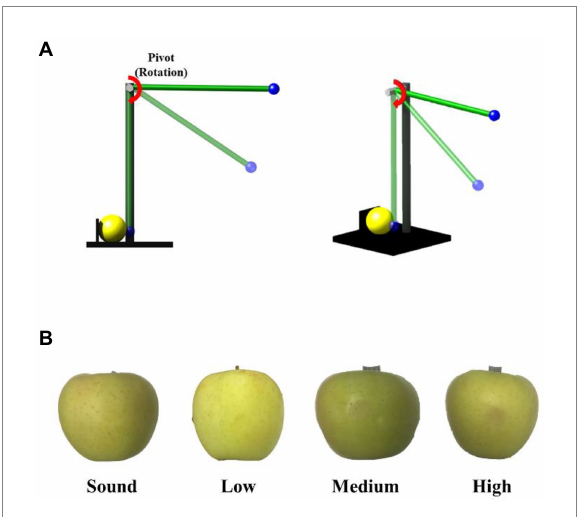
FIGURE 1 (A) Schematic of the apple-bruising device and (B) color image of sound and bruised